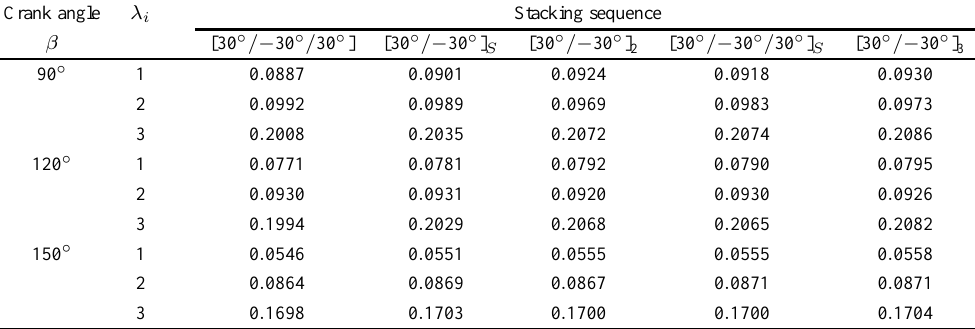
Non-dimensional natural frequencies for single fold composite cantilever folded plates